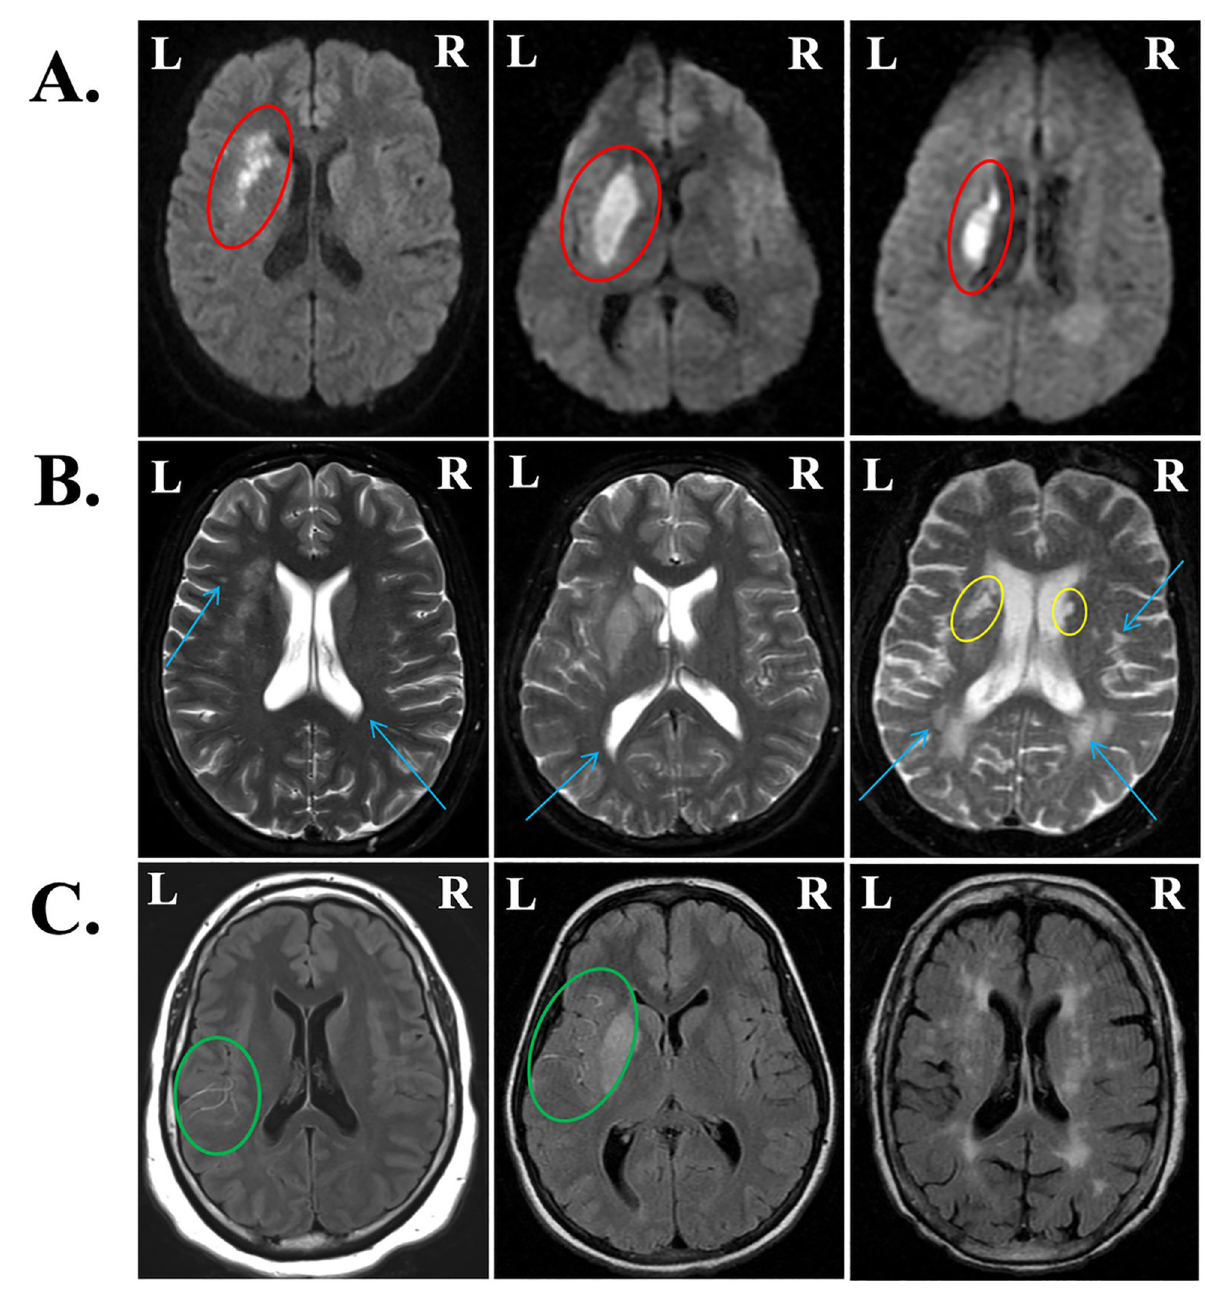
Fig 1. Representative images from patients with varying acute and chronic infarct volumes, leukoaraiosis, and hypoperfusion. (A) Diffusion- weighted images (DWI) display acute lesions (red ovals). (B) T2-weighted scans were used to visually score leukoaraiosis on the Fazekas scale (blue arrows) from 0 to 3 and visualize chronic infarcts where present (yellow ovals). From left to right, periventricular hyperintensities (PVH) were scored as 1, 1, and 3; deep white matter hyperintensities (DWMH) were scored as 1, 0, and 2. (C) FLAIR hyperintense vessels (FHV) are indicative of hypoperfusion in areas surrounding infarcted tissue (green ovals). From left to right, FHV scores were 5, 7, and 0 out of 12.